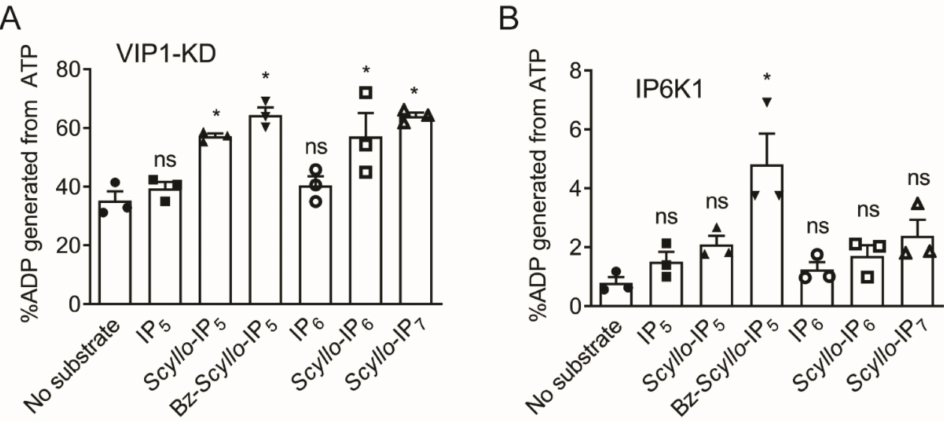
Figure 5. The effects of the myo - and scyllo -inositol phosphates upon ATPase activity of ( A ) VIP1-KD in presence of ATP (40 µ M) and IPn (100 µ M). ( B ) IP6K1 in presence of ATP (1 mM) and IPn (200 µ M). The graphs show individual data points and mean ± SEM from three independent experiments. Data was analyzed using one-way ANOVA to compare each condition with ATPase activity in the absence of substrate. * p ≤ 0.05; ns, not significant, p >